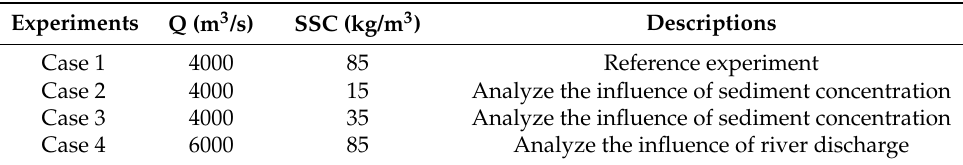
Figure 2. Daily river discharges and SSC at Lijin station between 19 June and 10 July 2007. Table 2. Details of the numerical experiments.